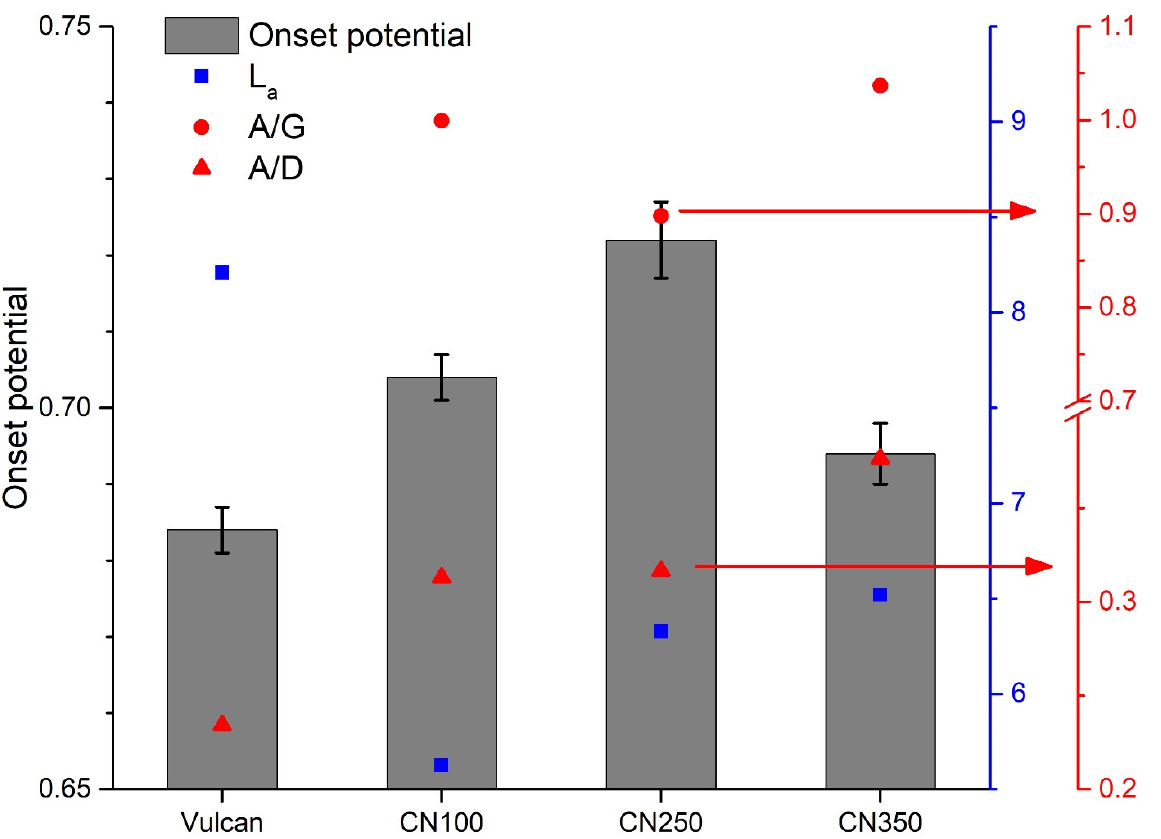
Figure 2. Grey column bar: onset potential (i.e., potential at 0.1 mAcm − 2 ); blue squares: lateral dimension of the graphitic cluster, L a (nm), which is inversely proportional to the I D /I G ratio; red circles: area of the A band divided by the D band; red triangles: area of the A band divided by the G band.